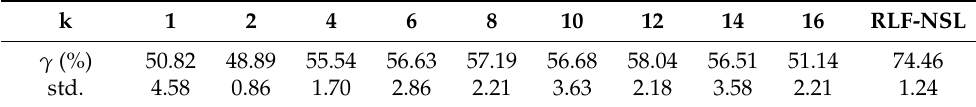
Table A4. The classification accuracy γ and the standard deviation (std.) on the IMDb dataset for N = 1200 by KNN with different k and by the RLF-NSL with β = 1.06.